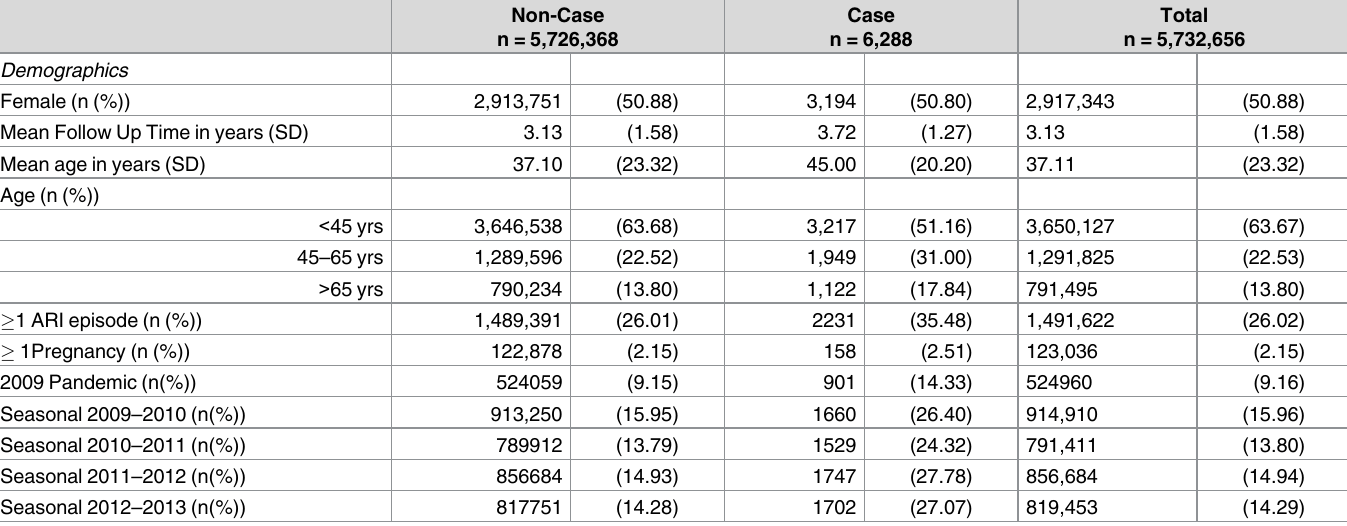
Table 1. Main characteristics of THIN population overall and by case status.